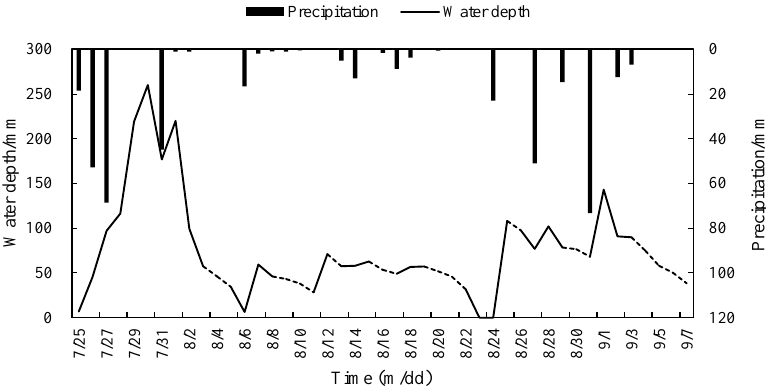
Figure 1. Water depth and precipitation of the paddy field during rice jointing-booting stage.